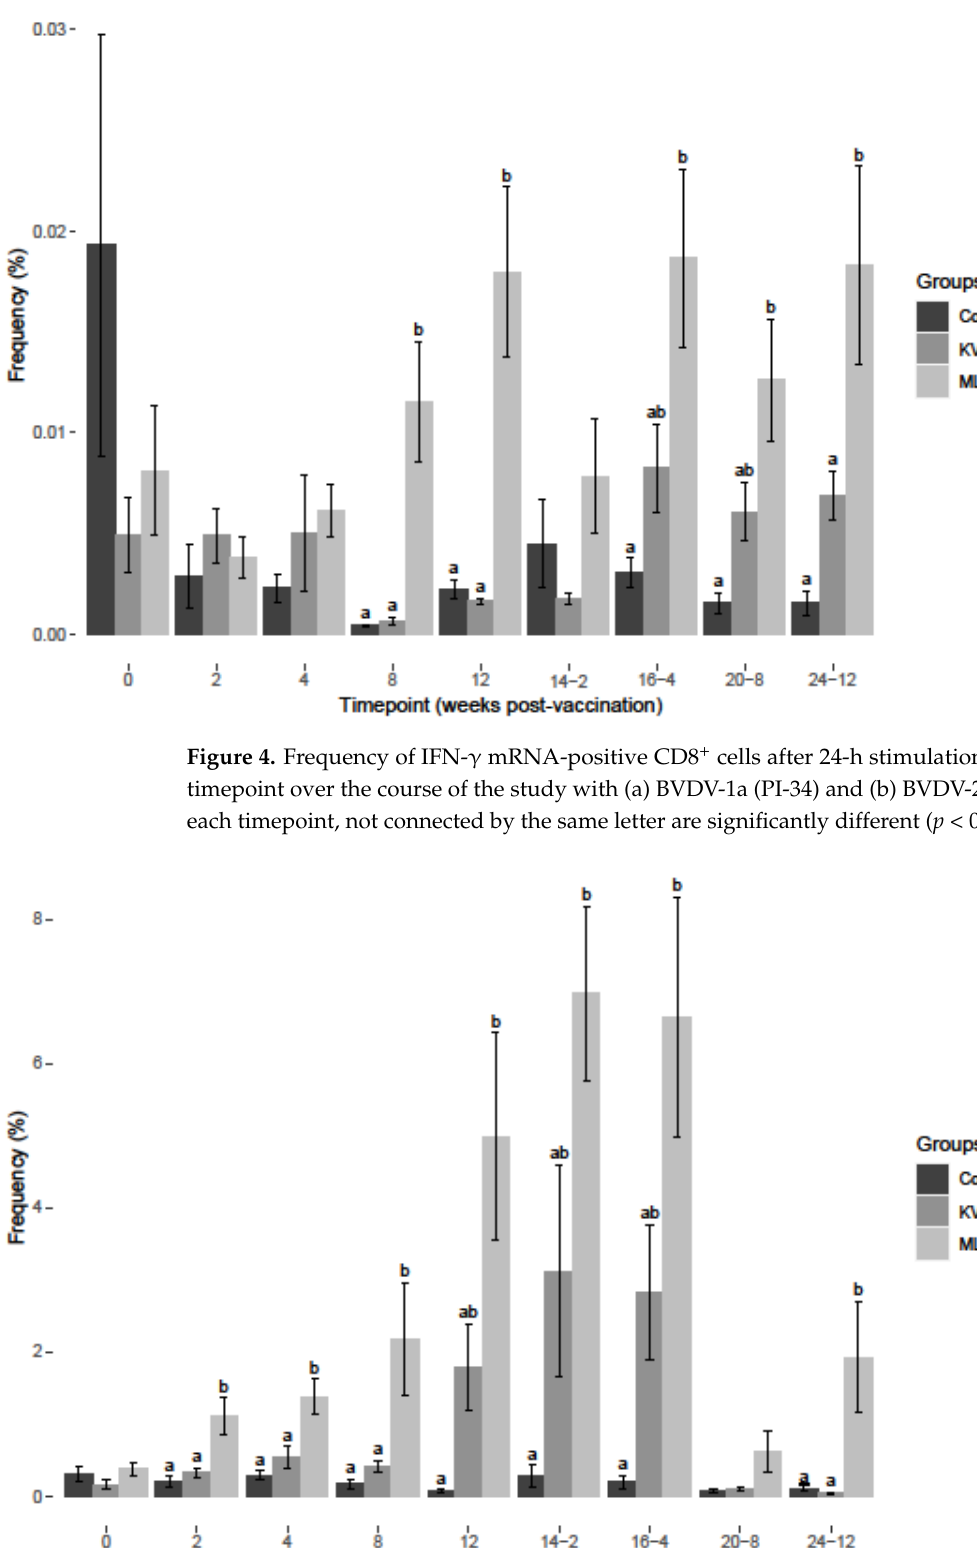
Figure 3. Frequency of IFN- γ mRNA -positive CD4 + cells after 24-hour stimulation at each respective timepoint over the course of the study with BVDV-2a (PI-28). Values at each timepoint, not con- nected by the same letter are significantly different ( p < 0.05).